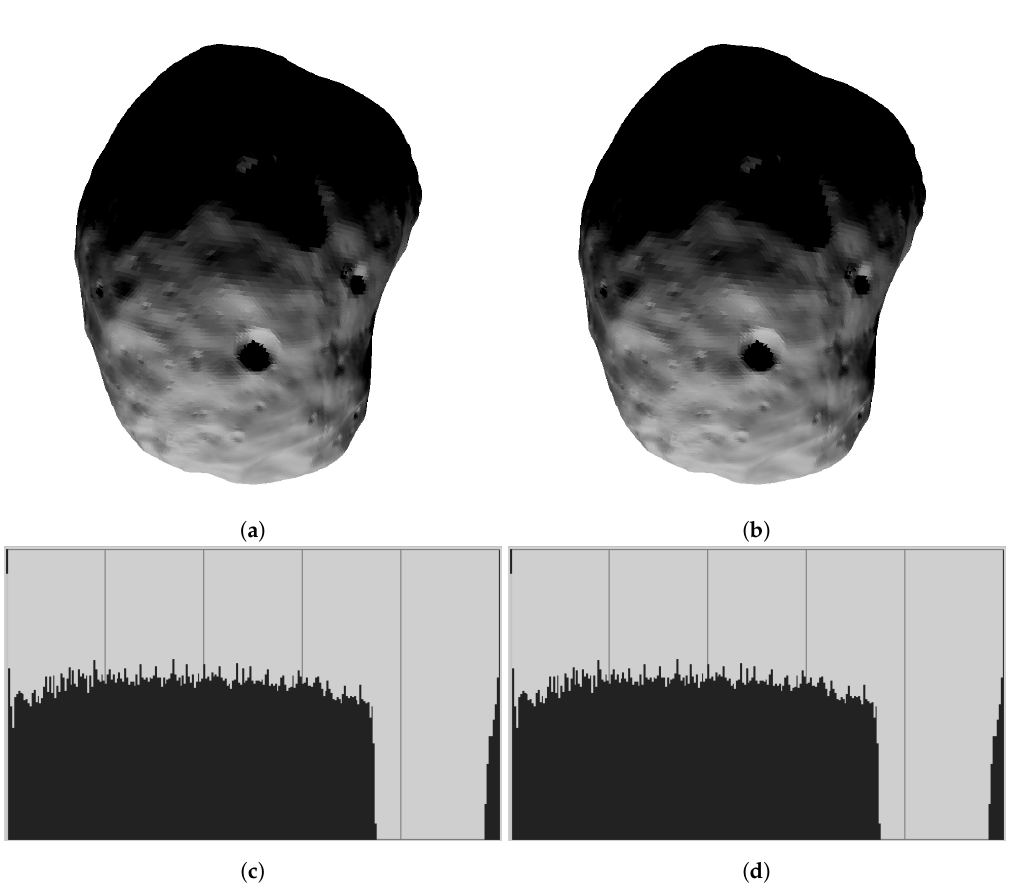
Figure 7. Comparison between irradiances with and without multiple scattering. ( a ) surface mesh, without multiple scattering; ( b ) Martian moon Phobos, 49152 triangle surface mesh, with multiple scattering. Maximal differences in irradiance compared to ( a ) are 2–3; ( c ) histogram corresponding to ( a ), multiple scattering toggled off; ( d ) histogram corresponding to ( b ), multiple scattering toggled